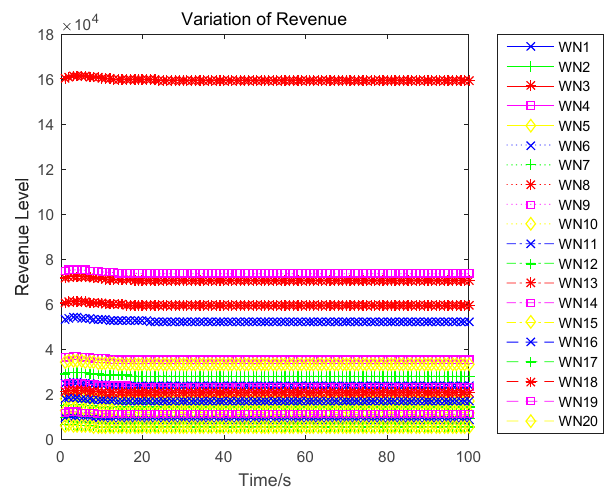
Figure 6. Dynamic of power level (the optimal state trajectory).